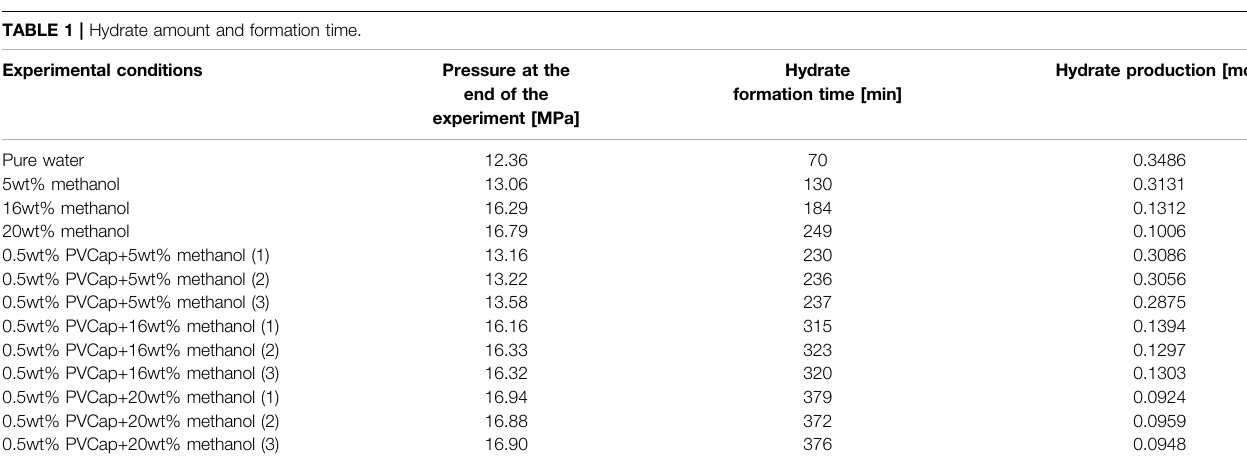
TABLE 1 | Hydrate amount and formation